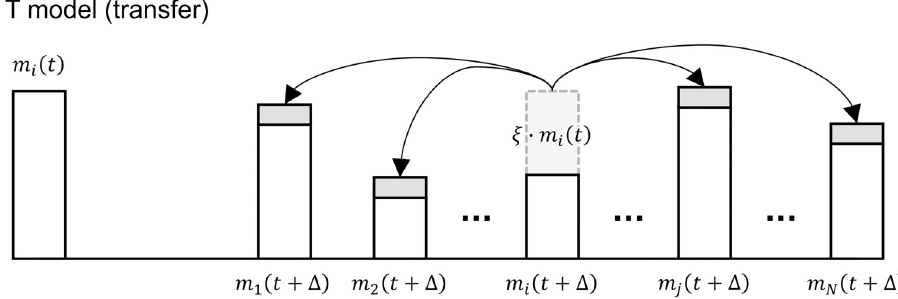
Fig 2. Redistribution models. T model (transfer), where ξ is the transfer rate. The wealth ξ � m from one agent to the other N agents, and this distribution is carried out by all N agents in every period t p